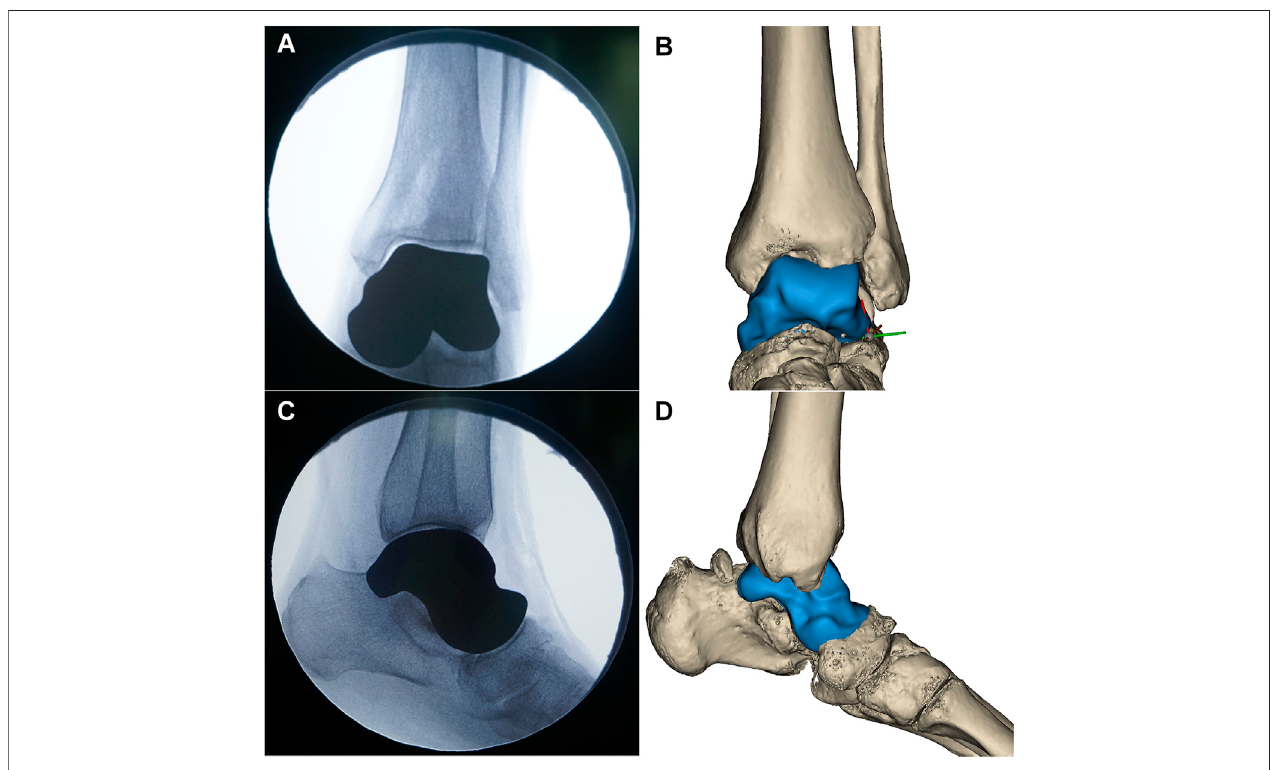
FIGURE 5 | The position of the 3D printed talar prosthesis was con fi rmed by postoperative radiography (A,C) , and matched with the preoperative 3D reconstructed results (B,D) .